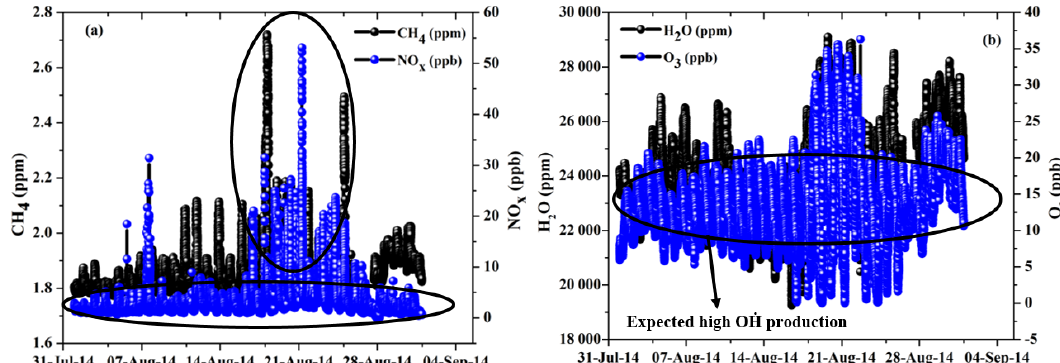
Figure 10. Time series analysis of (a) CH 4 vs. NO x and (b) H 2 O vs. O 3 .